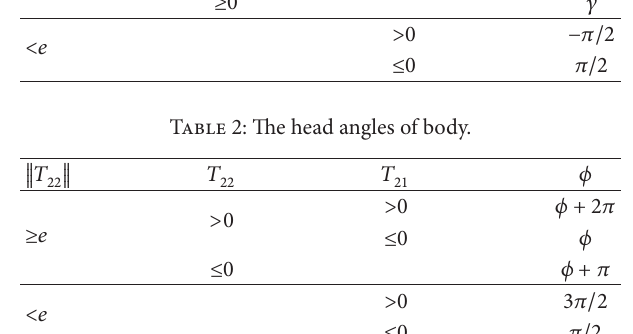
applied in aerial remote sensing system contains three types of sensor, GNSS, IMU, and imaging sensor with some lever arms among them. It can be called multilevel rigid lever arm, generally [28]. The multilevel rigid lever arm mechanism is shown in Figure 2. When the GNSS antenna is installed in top of airplane, there exists a lever arm towards the IMU. The first lever arm R b I describes the spatial difference vector between measurement centers of IMU and GNSS antenna. The second lever arm, R b II , denotes the spatial difference vector between sensing centers of IMU and imaging sensor. The motion of IMU may be precisely solved by first lever arm compensation. However, only when the second lever arm is compensated, can the motion solution transfer into the sensing center of imaging sensor [29,